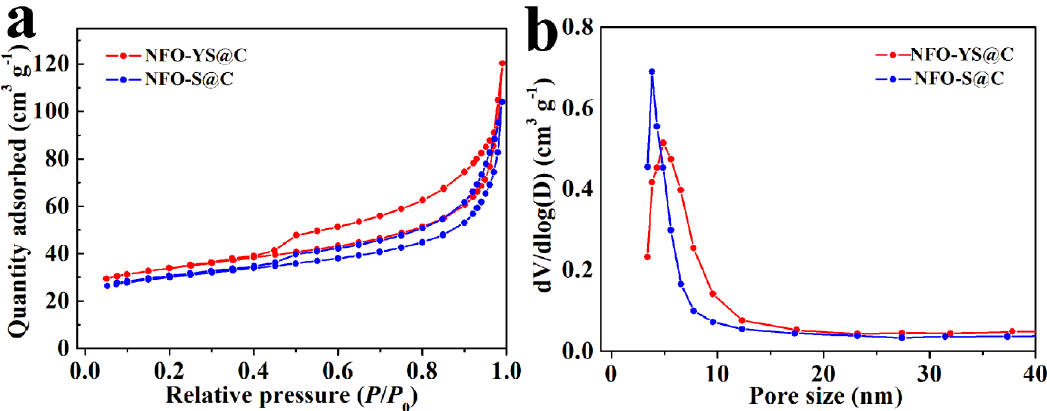
Figure 4. ( a ) The N 2 adsorption–desorption isotherms of NFO-S@C and NFO-YS@C, ( b ) the corresponding pore size distributions.